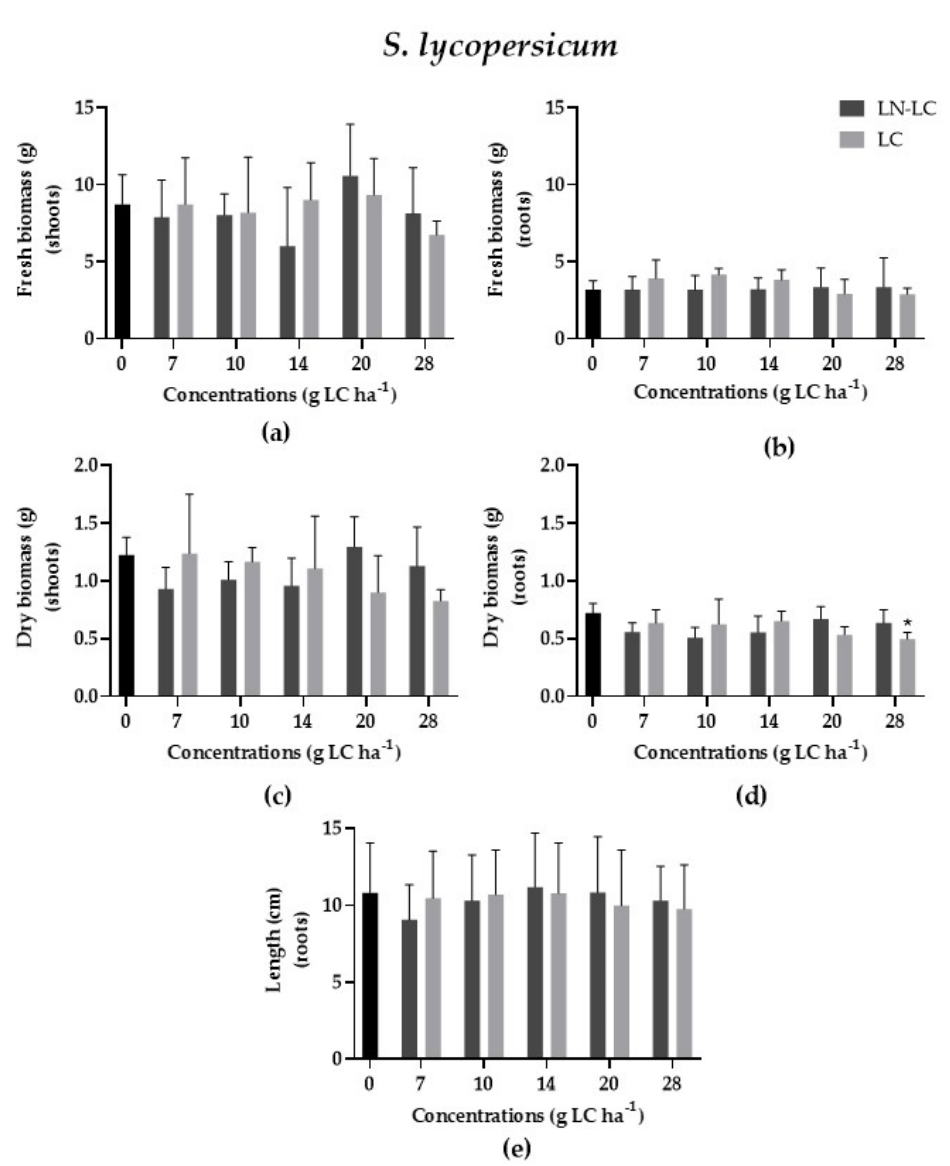
Figure 2. Variation of fresh biomass of shoots and roots ( a , b ), dry biomass of shoots, and roots ( c , d ) and length ( e ) of roots of S. lycopersicum after exposure to LC (light) and LN–LC (dark). The concentrations tested are based on the amount of LC. Results are represented by mean ± SD values. Asterisks mark the significant differences compared to the control group (0 g LC ha − 1 ) (( a , b ) p < 0.05, Dunnett; ( c – e ) p < 0.05,